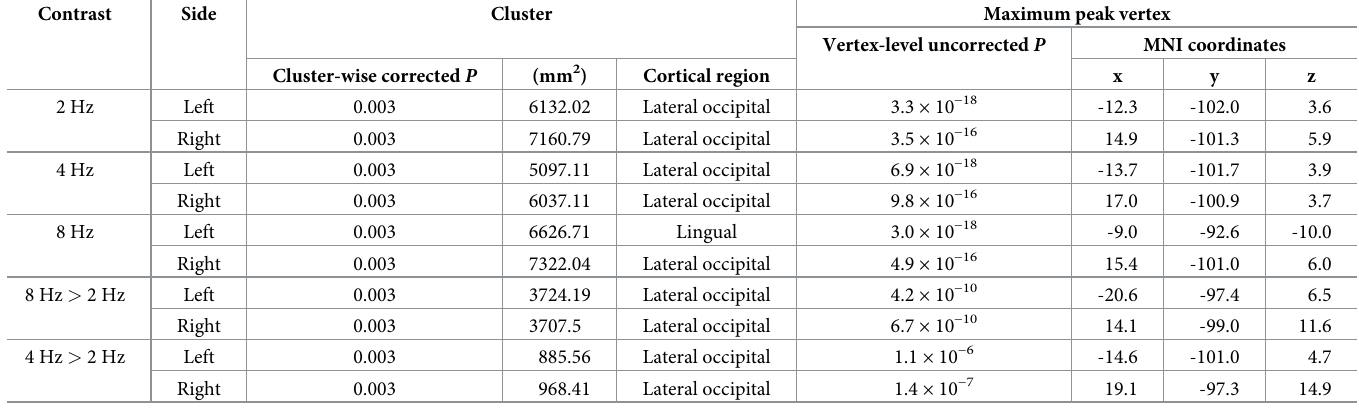
Table 2. Statistically significant clusters for each contrast by the group analysis (n = 29).